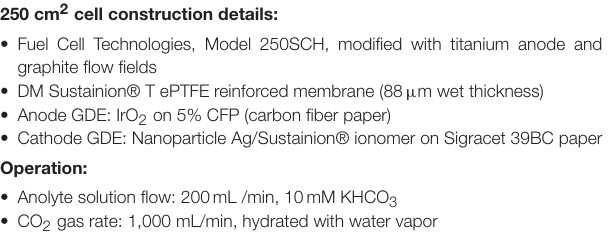
TABLE 4 | 250 cm 2 CO 2 cell configuration details.